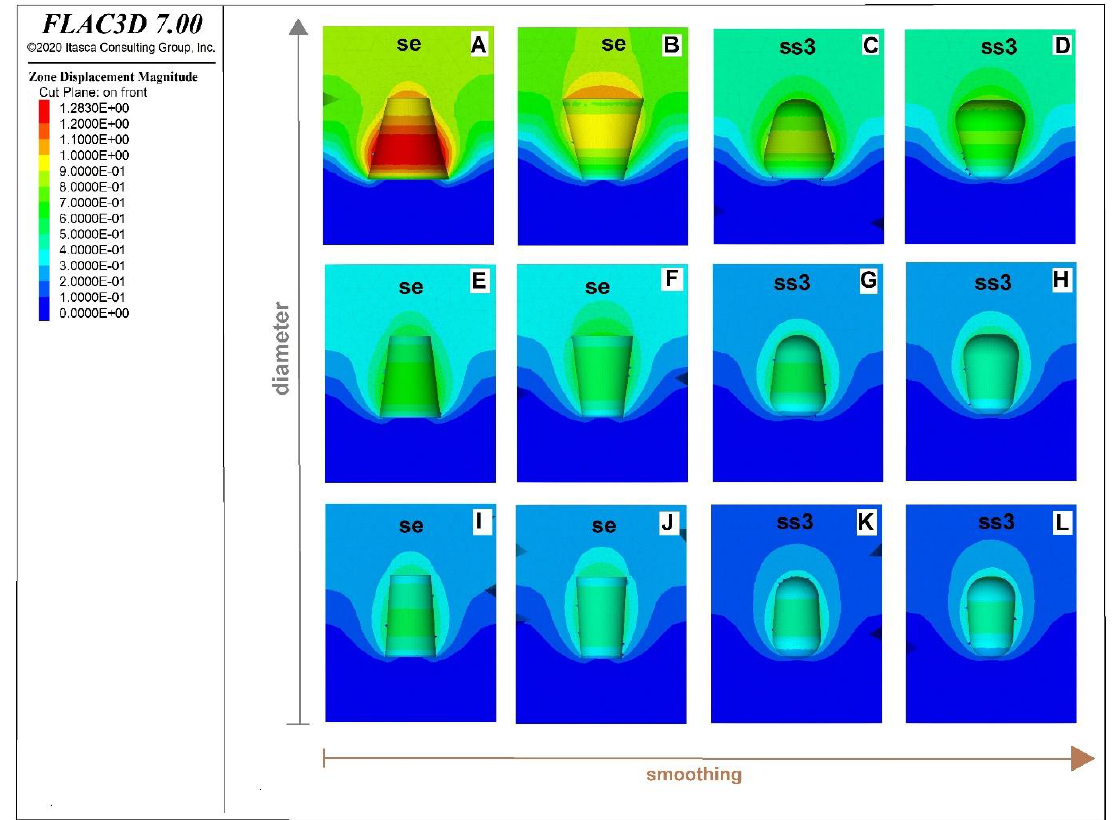
Figure 6. The comparison of displacements in caverns with the enlarged top and bottom; the first injection period: ( A – D ) maximum initial diameter of 120 m, ( E – H ) maximum initial diameter of 90 m, ( I – L ) maximum initial diameter of 75 m.